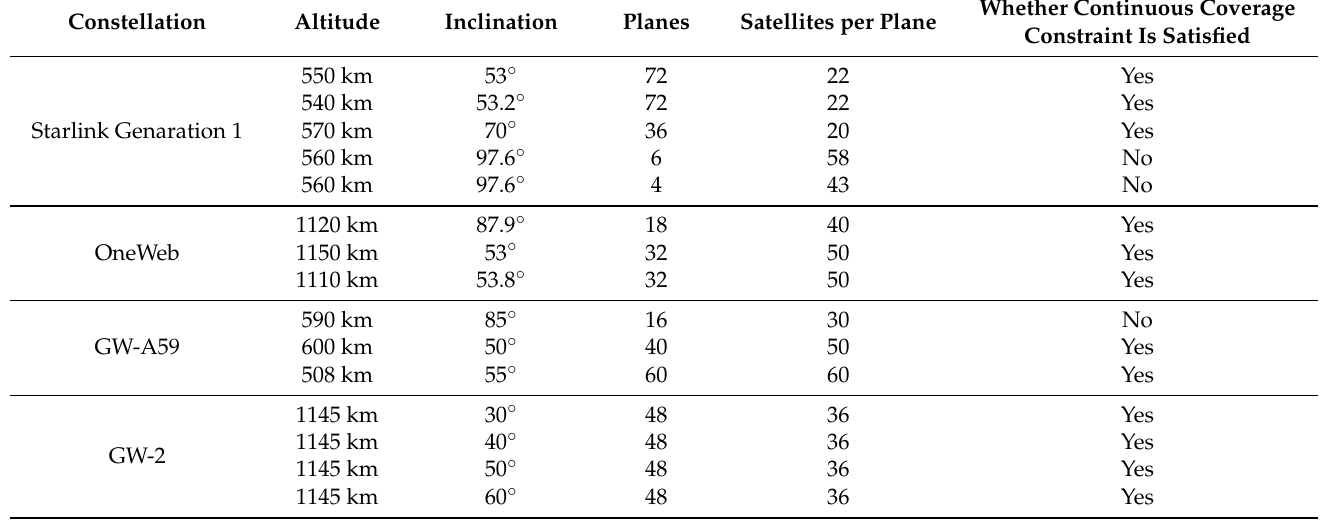
Table 1. Summary of several mega constellation